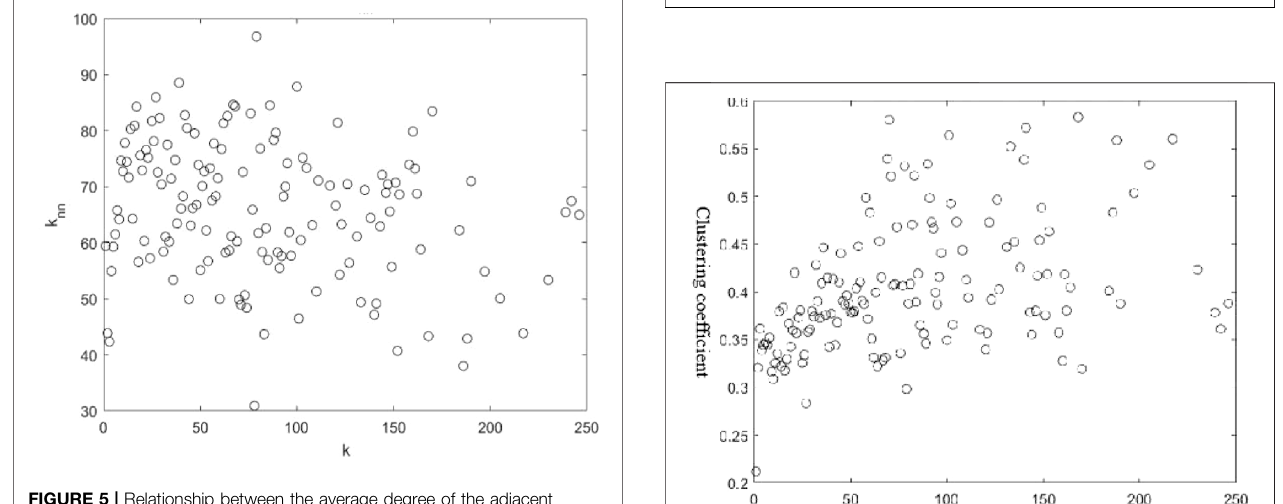
Frontiers in Physics |